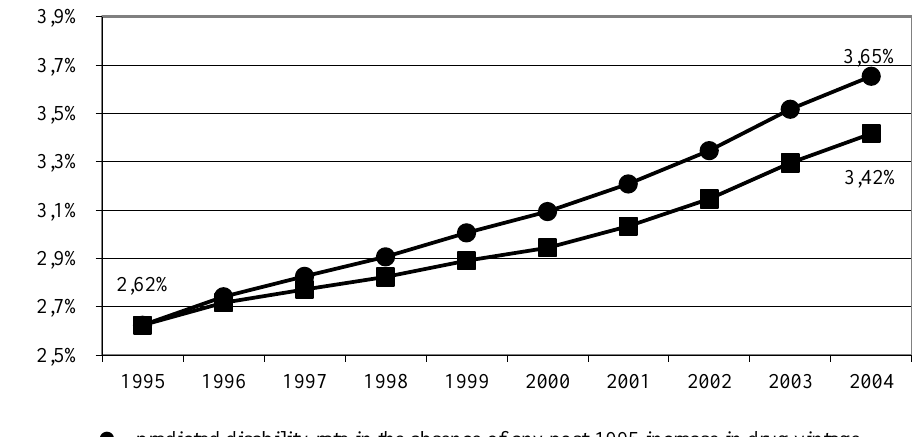
Figure 1: Predicted disability rate in year t (t=1996, …, 2004), in the absence of any post-1995 increase in drug